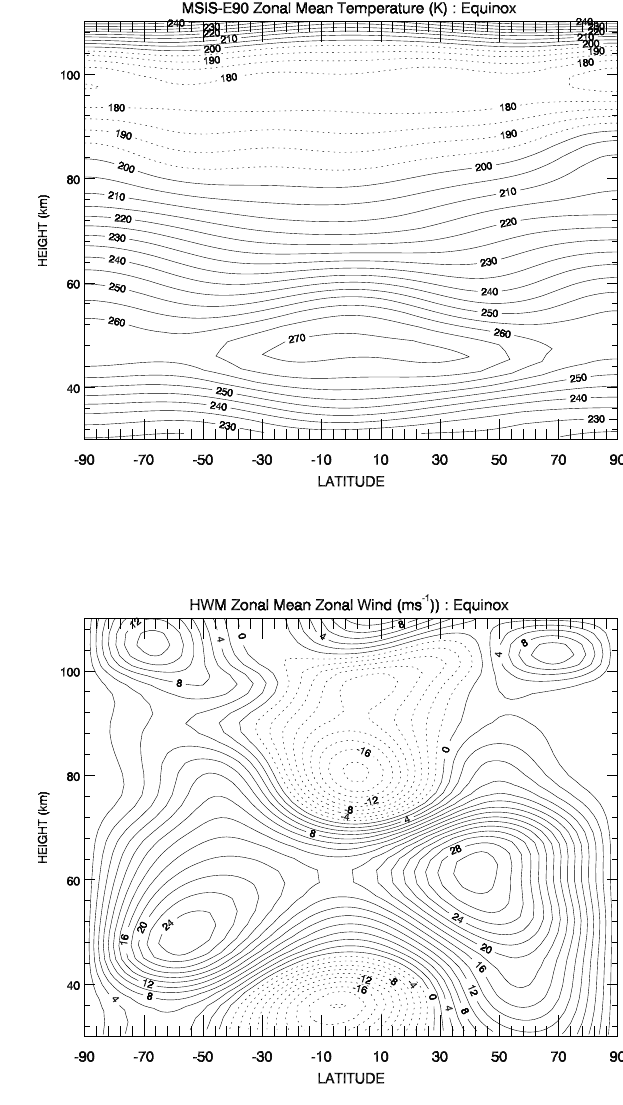
Fig. 2. Zonal mean temperature ( K ) as given by MSIS-E90 (top), and zonal mean zonal wind as given by HWM (ms − 1 ) (bottom) for equinox. Positive values denote eastward